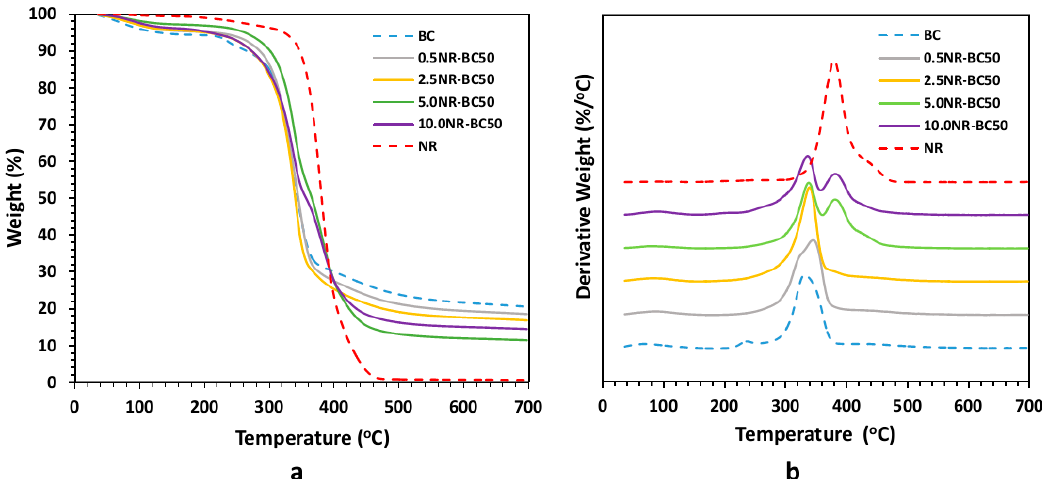
Figure 9. Thermal gravimetric analysis (TGA) ( a ) and differential thermal analysis (DTA) ( b ) curves of BC, NR, and NR–BC films.